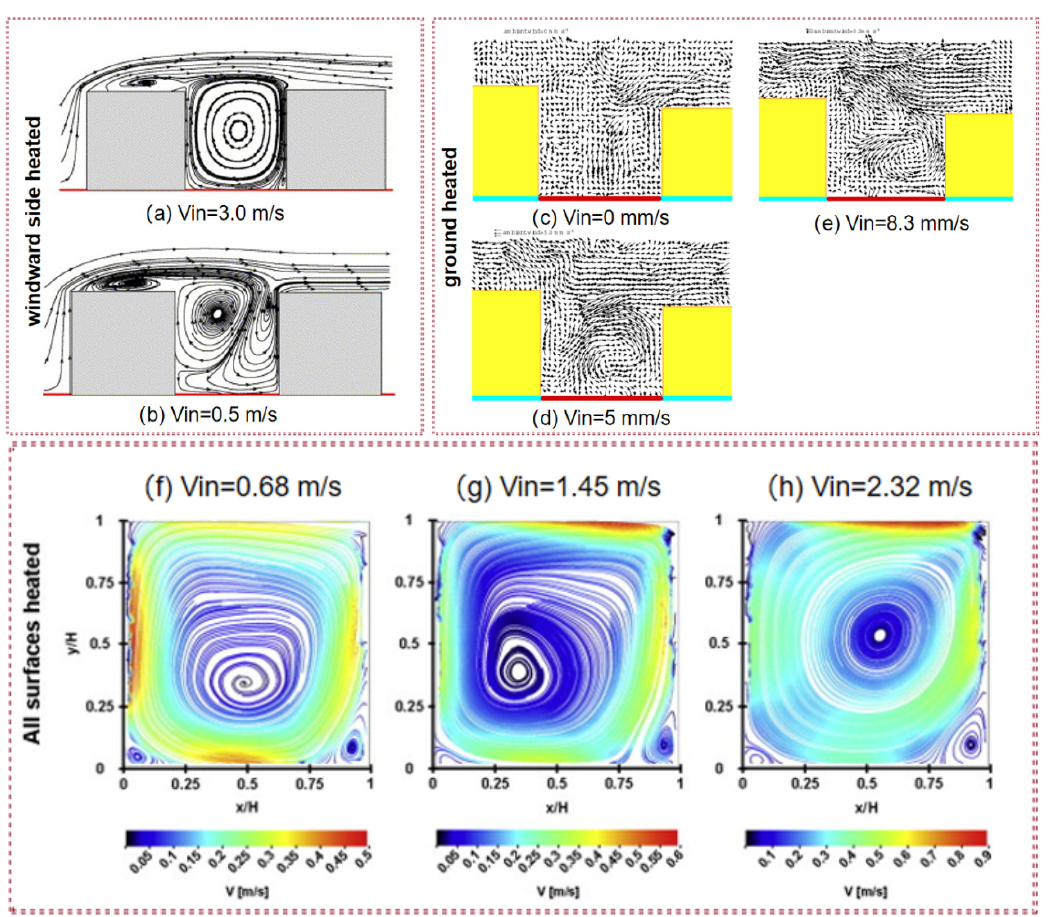
Figure 1. Airflow profiles at different wind speeds: ( a , b ) CFD results with the windward side heated. Adapted with permission from Ref. [130]. 2005, Elsevier; ( c – e ) water tank experiment results with the ground heated. Adapted with permission from Ref. [70]. 2003, Springer Nature; ( f – h ) wind tunnel experiment results with all surfaces heated. Adapted with permission from Ref. [131]. 2013, Elsevier.